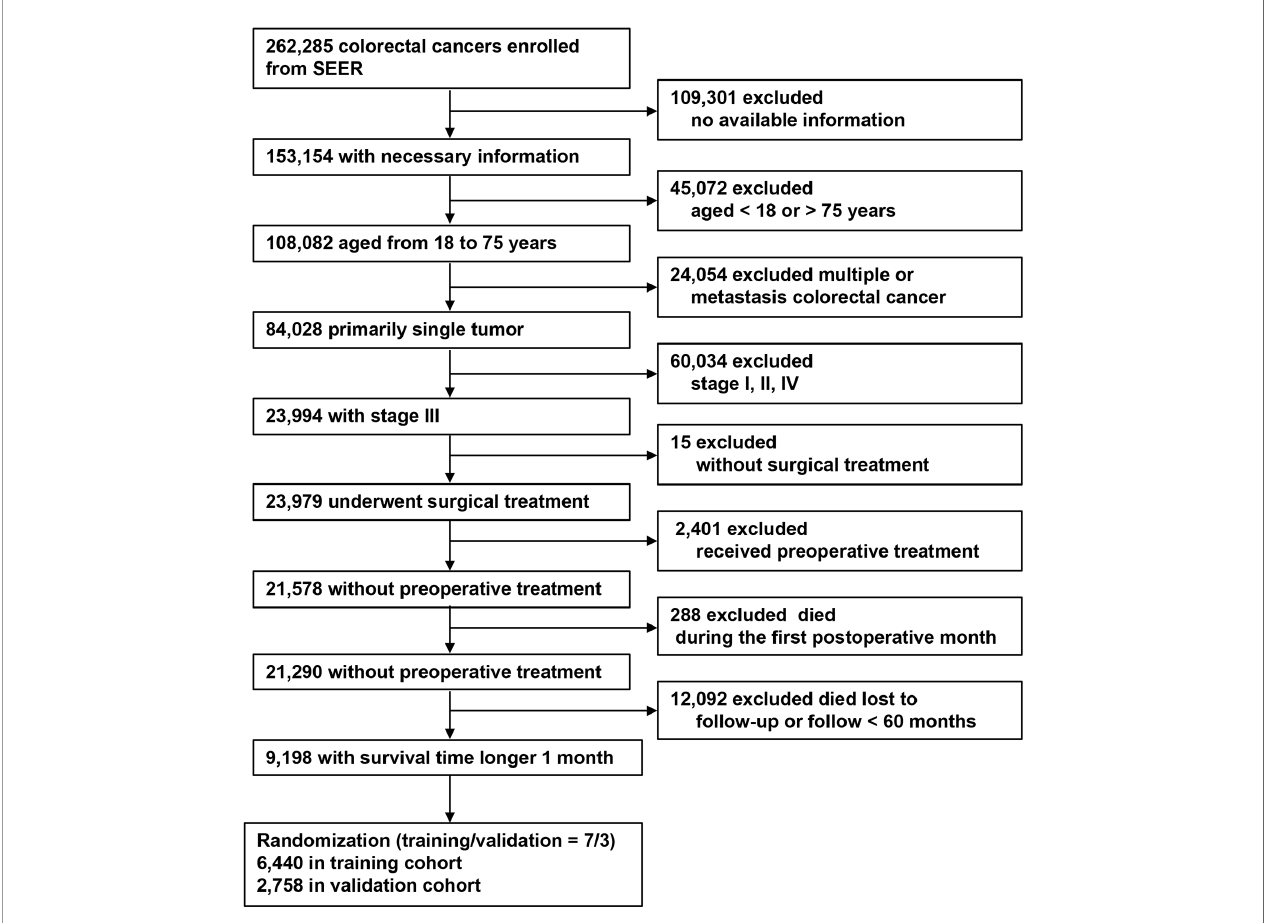
FIGURE 1 | Flow chart for patient